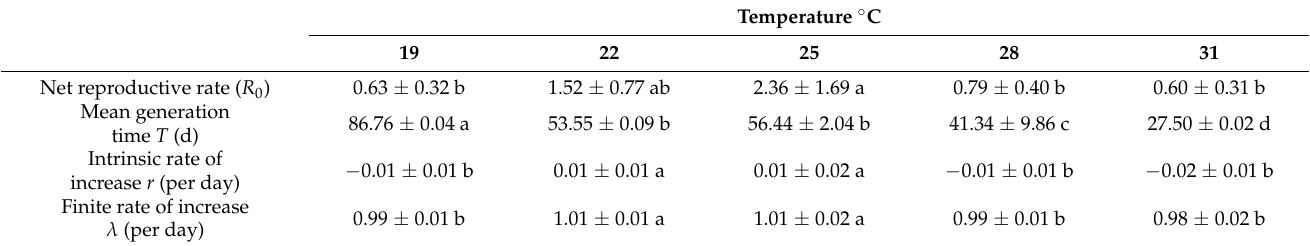
Table 3. Population parameters of Riptortus pedestris at different temperatures.